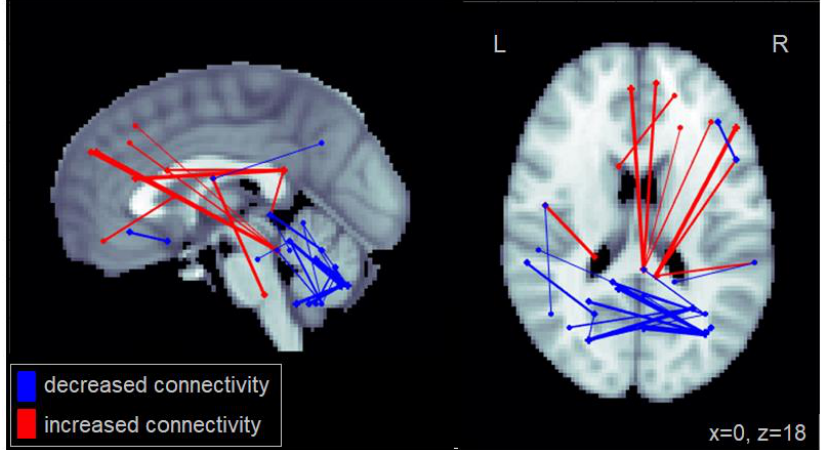
Figure 3. Altered functional connectivity associated with standard deviation in steering observed among patients with MCI. Blue lines denote functional connections with reduced connectivity associated with greater lane deviations, red lines denote increased connectivity (significant at FDR = 0.05). Connections are shown as projections in the sagittal and axial plane, with MNI anatomical underlays (slices at x = 0 and z = 18 respectively).